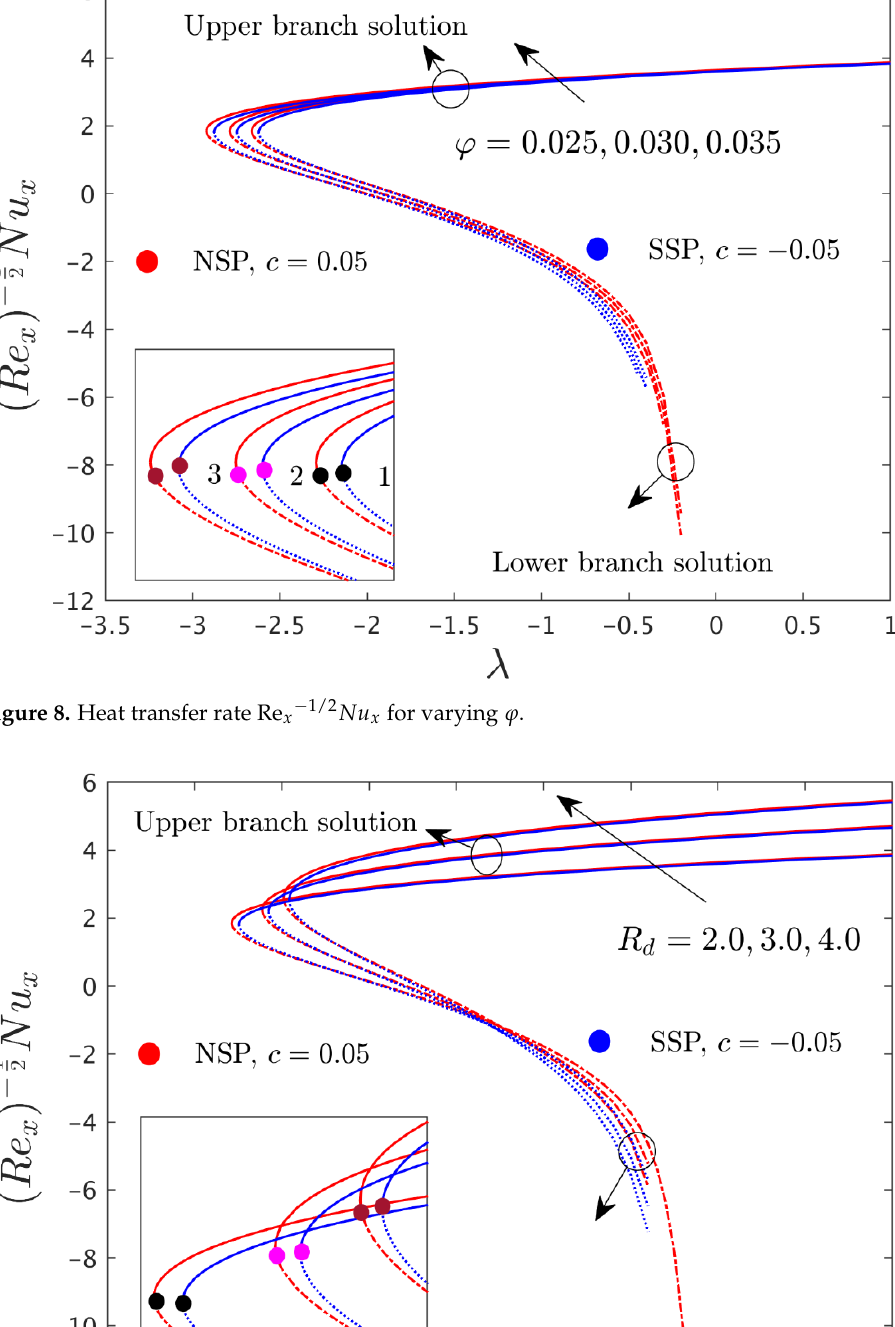
obtained: − 2.78750, − 2.61180, and − 2.48908. The absolute values of the bifurcation values declined, which showed that the boundary layer separation escalated.